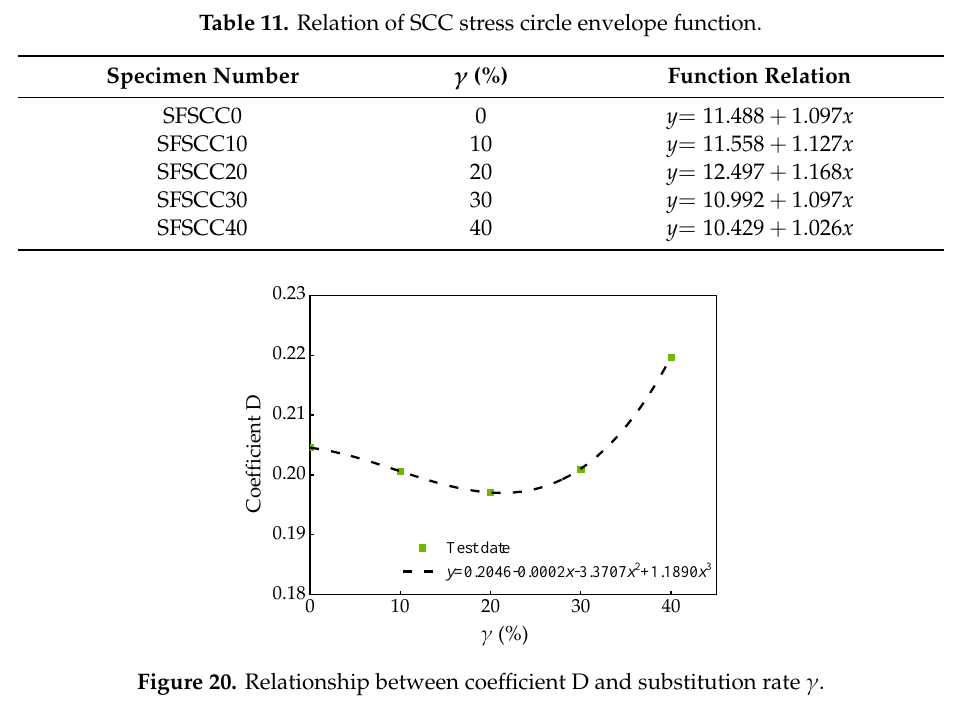
Figure 19. Relationship between τ / σ 0 and σ / σ 0 .